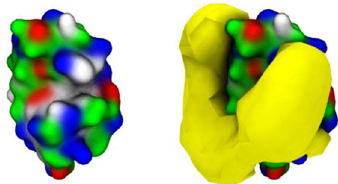
Figure 9. [C 4 F 9 SO 3 ] − micelle occupancy in Lys–Lys interface (only one Lys molecule represented for the sake of clarity).